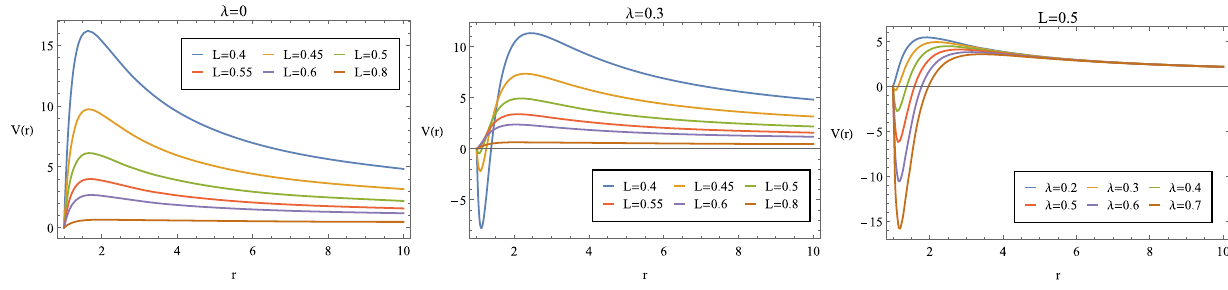
Fig. 5 The effective potential for the AdS black hole with negative